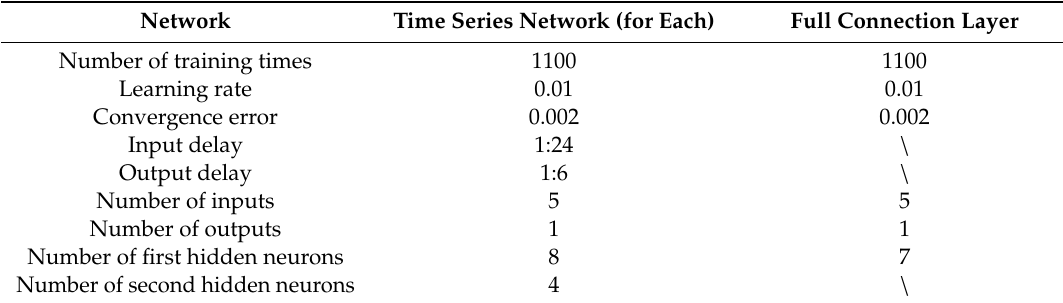
Table 1. Data used in the experiment.